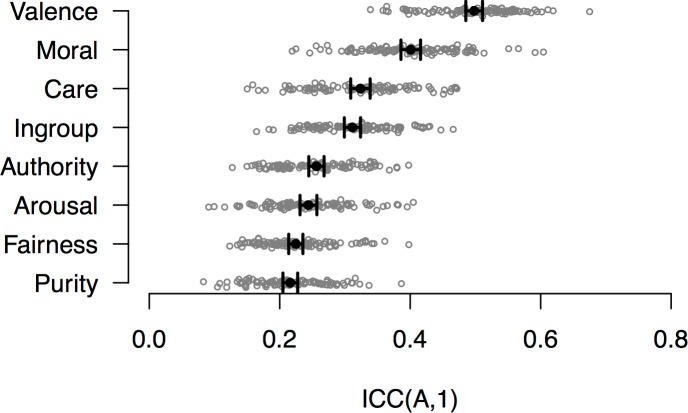
Distributions of intra-class correlation coefficients for each rating dimension across image batches.Grey points represent individual observations (i.e., each of the 99 batches). Black points represent the average ICC(A,1) across all batches, with error bars representing 95% CIs.